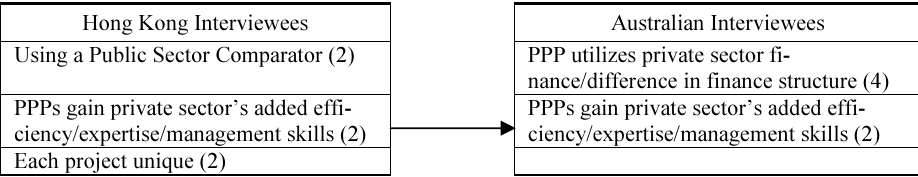
Table 7. Question 2 – How would you compare PPP with traditional procurement methods?